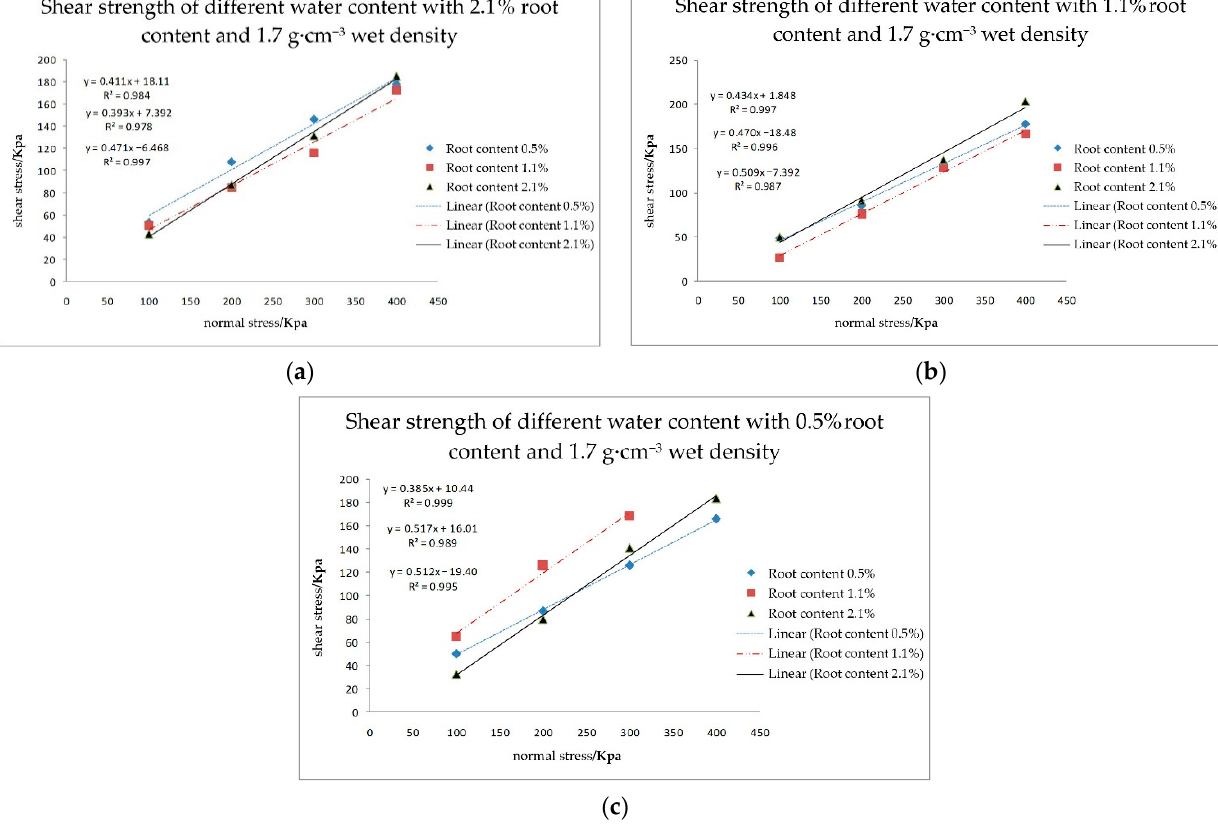
Figure 6. τ s - σ s scatter plot and fitting line of each sample with root content of 2.1%, 1.1%, and 0.5%. Note: ( a ) 2.1% root content, 1.7 g·cm − 3 wet density. ( b ) 1.1% root content, 1.7 g·cm − 3 wet density. ( c ) Table 8. Coefficient table of fitted equations with different moisture contents and root contents at the same volume weight.